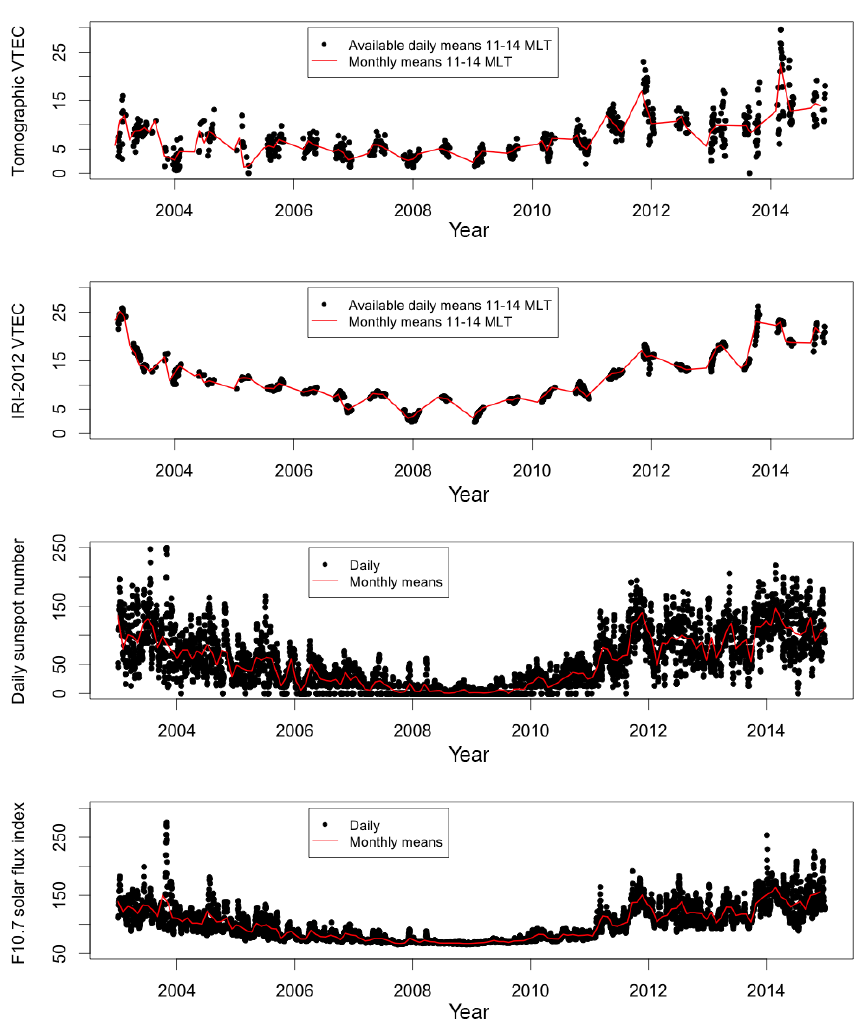
Figure 10. VTEC values over Kokkola averaged from 11:00 to 13:00MLT vs. corresponding IRI-2012 model values, sunspot number and solar flux index